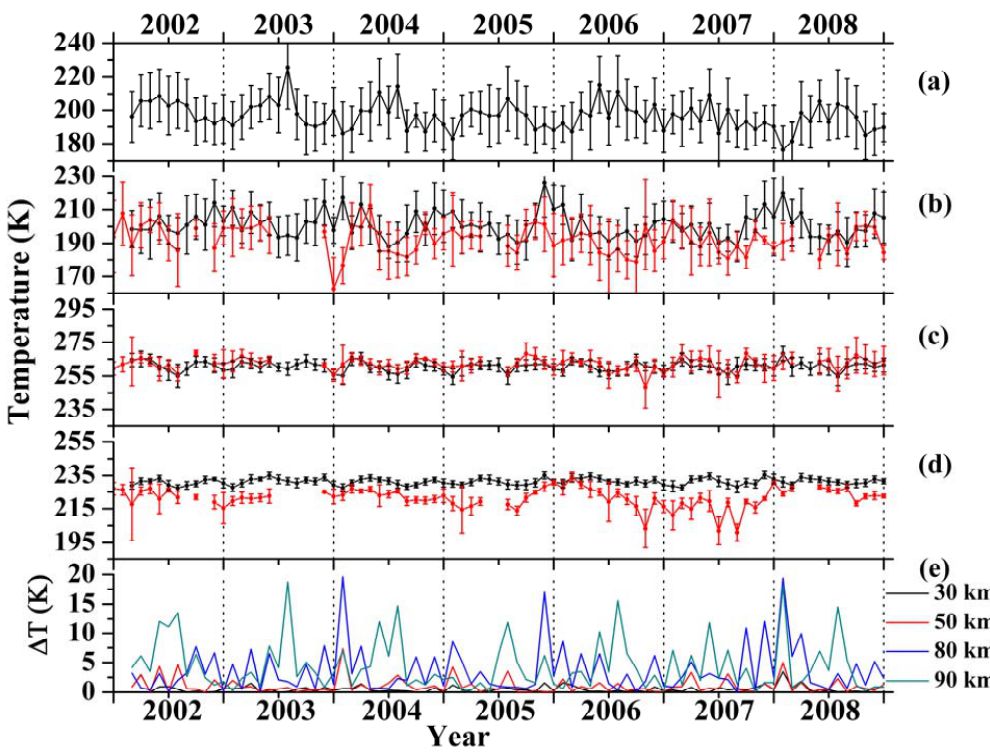
Fig. 6. Monthly mean temperatures (filled circle with solid line) along with standard deviations (vertical bars) for SABER (black) and lidar (red) at (a) 90 km, (b) 80 km, (c) 50 km, (d) 30 km. (e) Monthly mean absolute temperature deviation ( Δ T) between diurnal and nocturnal temperature for SABER.